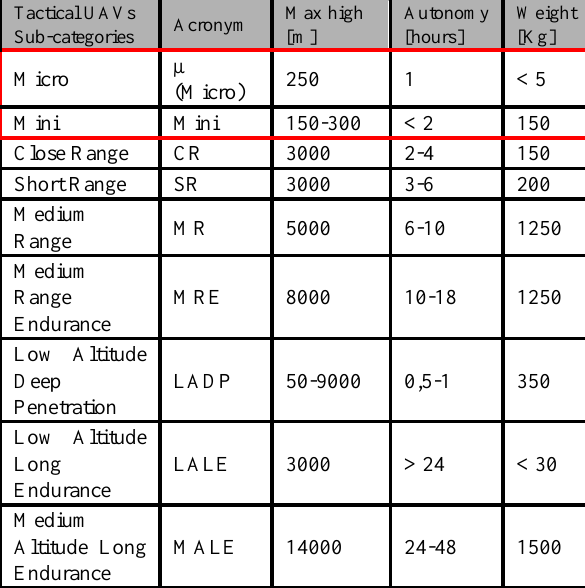
Table 1. Classification of Tactical UAVs by the Unmanned Vehicle Systems International Association